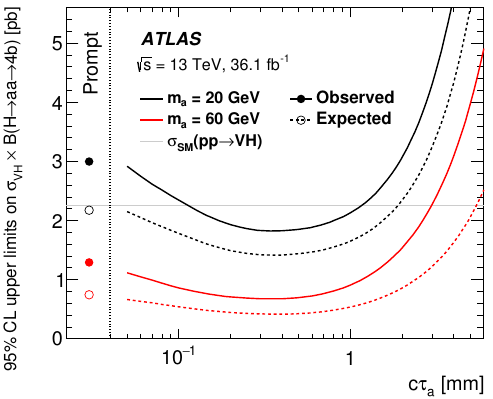
Figure 10. Summary of the expected and observed combined 95% CL upper limits on (cid:27) 4 b ) with prompt and long-lived a -bosons. Expected (observed) limits for prompt a -bosons aa ! are shown as empty ((cid:12)lled) circles. Expected (observed) limits for long-lived signals are shown as dashed (solid) lines for two signal scenarios: m a = 20 and 60